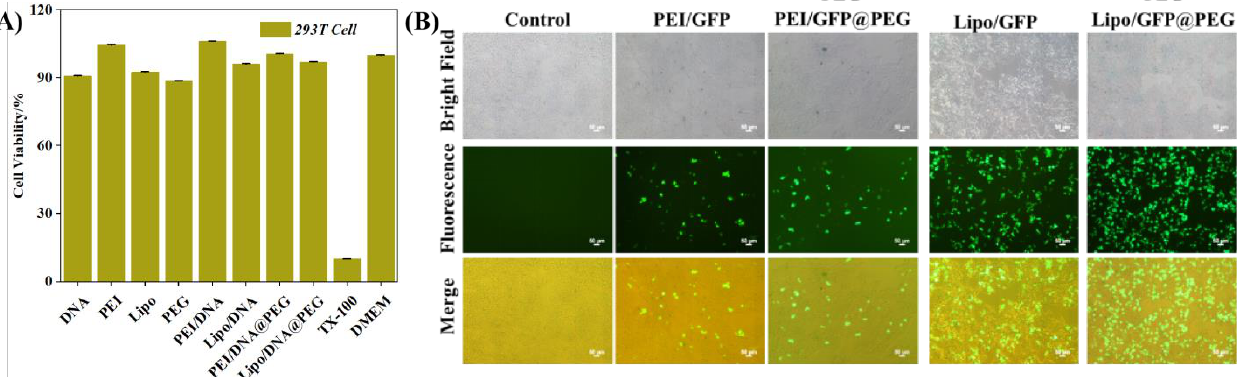
Figure 4. ( A ) The cytotoxicity of PEI/DNA@PEG and Lipo/DNA@PEI against 293T ( n = 5). ( B ) 24 h images of transfected cells after being treated with PEI/GFP, PEI/GFP@PEG, Lipo/GFP, and Lipo/GFP@PEG. The addition of PEG does not destroy the release of GFP.